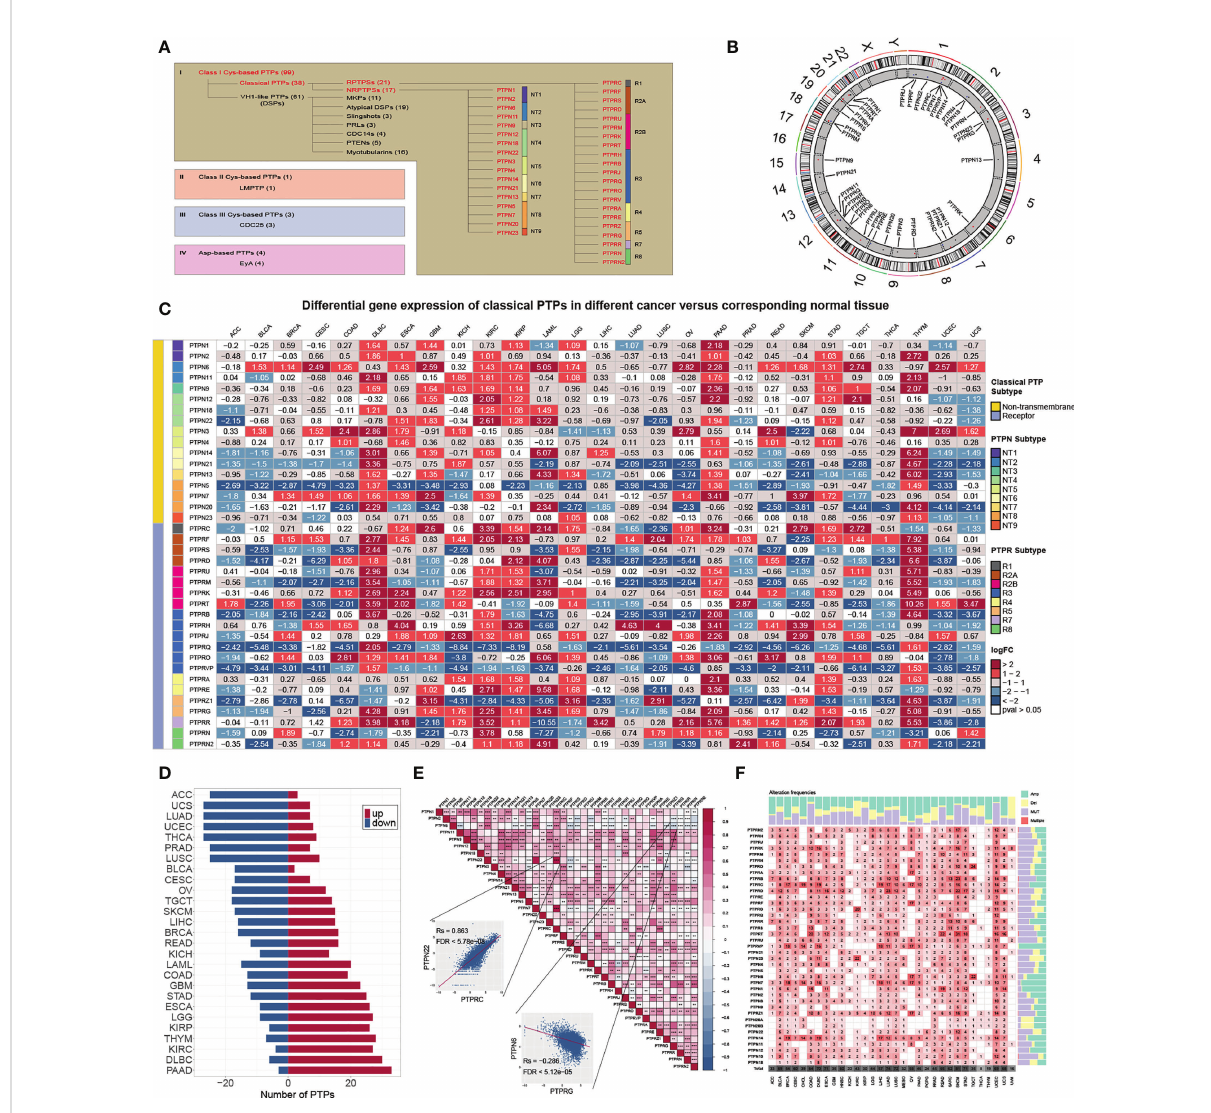
FIGURE 1 Genetic and expression landscape of classical PTPs in human cancer. (A) Classi fi cation of PTP superfamily. (B) Gene location on the chromosome. (C) Differential gene expression of classical PTPs across 27 types of cancer. (D) The proportion of signi fi cantly dysregulated classical PTPs for each tumor. (E) Correlation among the expression of classical PTPs in pan-cancer. (F) Detailed heatmap of alteration